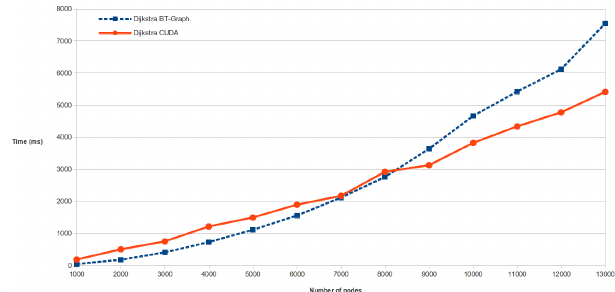
Figure 12. Anexecutiontimecomparisonof serial and parallel Dijkstra’s